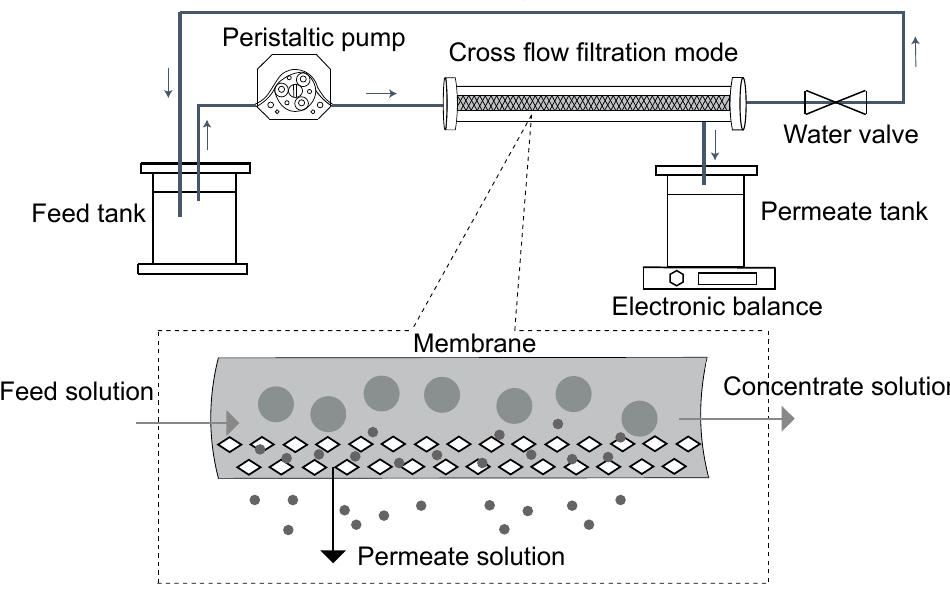
Figure 1. Schematic diagram of the membrane filtration system.